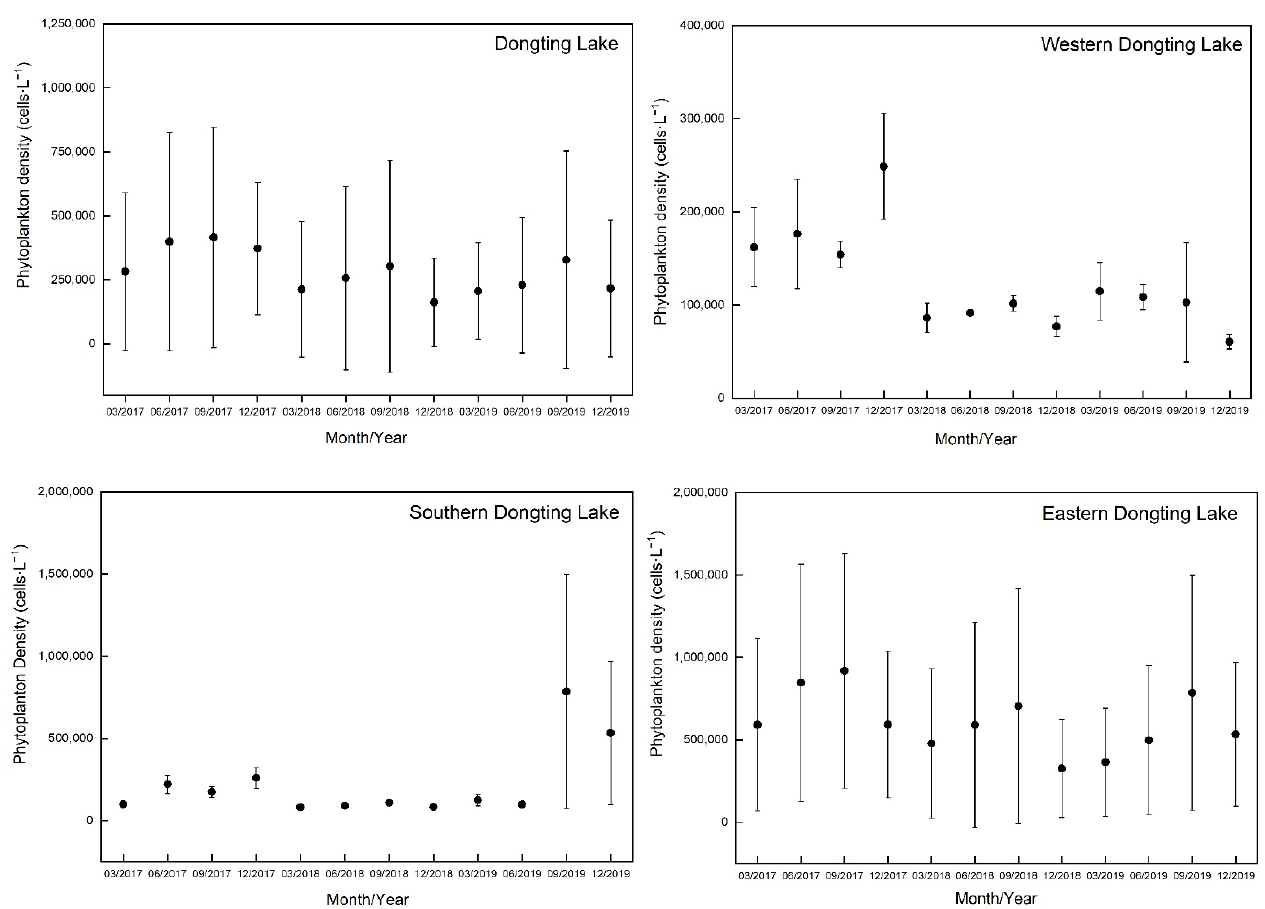
Figure 2. Temporal and spatial variation characteristics of phytoplankton density in Dongting Lake. There were 15 dominant species that belonged to five phyla from March 2017 to December 2019, with the dominance ranging from 0.020 to 0.143, 0.021 to 0.041, 0.020 to 0.337, 0.020 to 0.048, and 0.020 to 0.036 in Cyanobacteria, Chlorophyta, Bacillariophyta, Cryptophyta, and Miozoa, respectively. Fragilaria radians (Kützing) D.M.Williams & Round and Aulacoseira granulata (Ehrenberg) Simonsen were the dominant populations in all seasons, and the dominant area of Aulacoseira granulata (Ehrenberg) Simonsen could reach a peak of 0.337 in March 2019. In addition, Oxynema acuminatum (Gomont) Chatchawan, Kom á rek, Strunecky, Smarda & Peerapornpisal, Anabaena azotica Ley, and Pseudanabaena catenata Lauterborn became dominant species in September 2019 (Figure